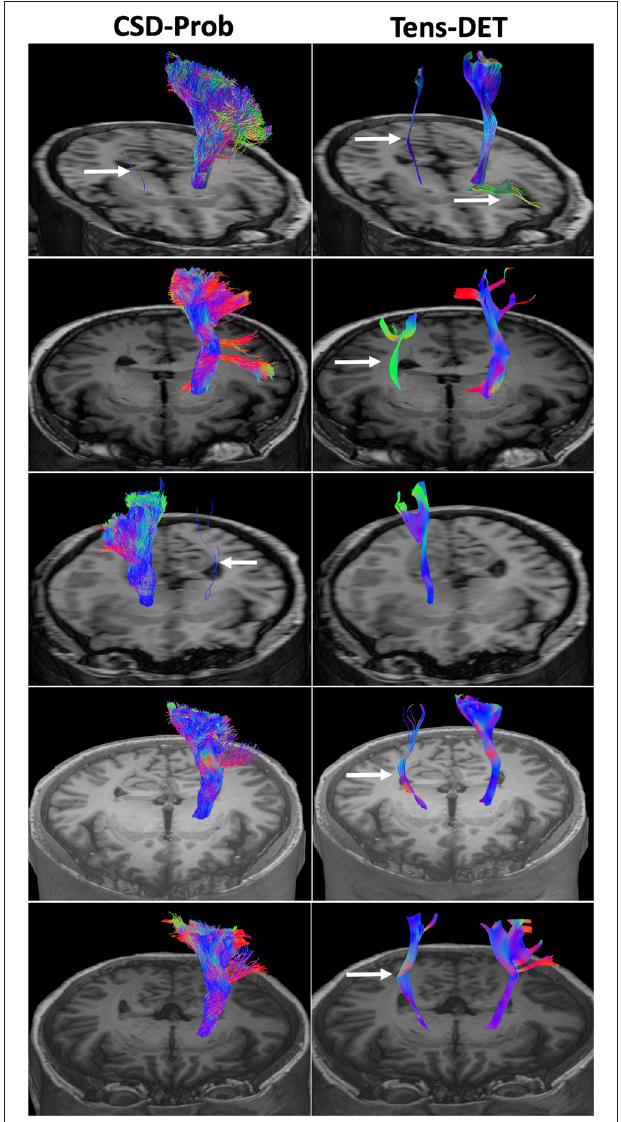
FIGURE 3 | Comparison of the CSD-Prob and Tens-DET approaches in 5 subjects. The left panels show the 3D reconstruction of the CST by the CSD-Prob with the fan-like configuration of the cortical projections of the CST. The right panels show the CST by the Tens-DET approach with a straight trajectory to the dorsal part of the precentral gyrus, absence of the ventral part of the motor CST, and more prevalence of spurious fibers than the CSD-Prob